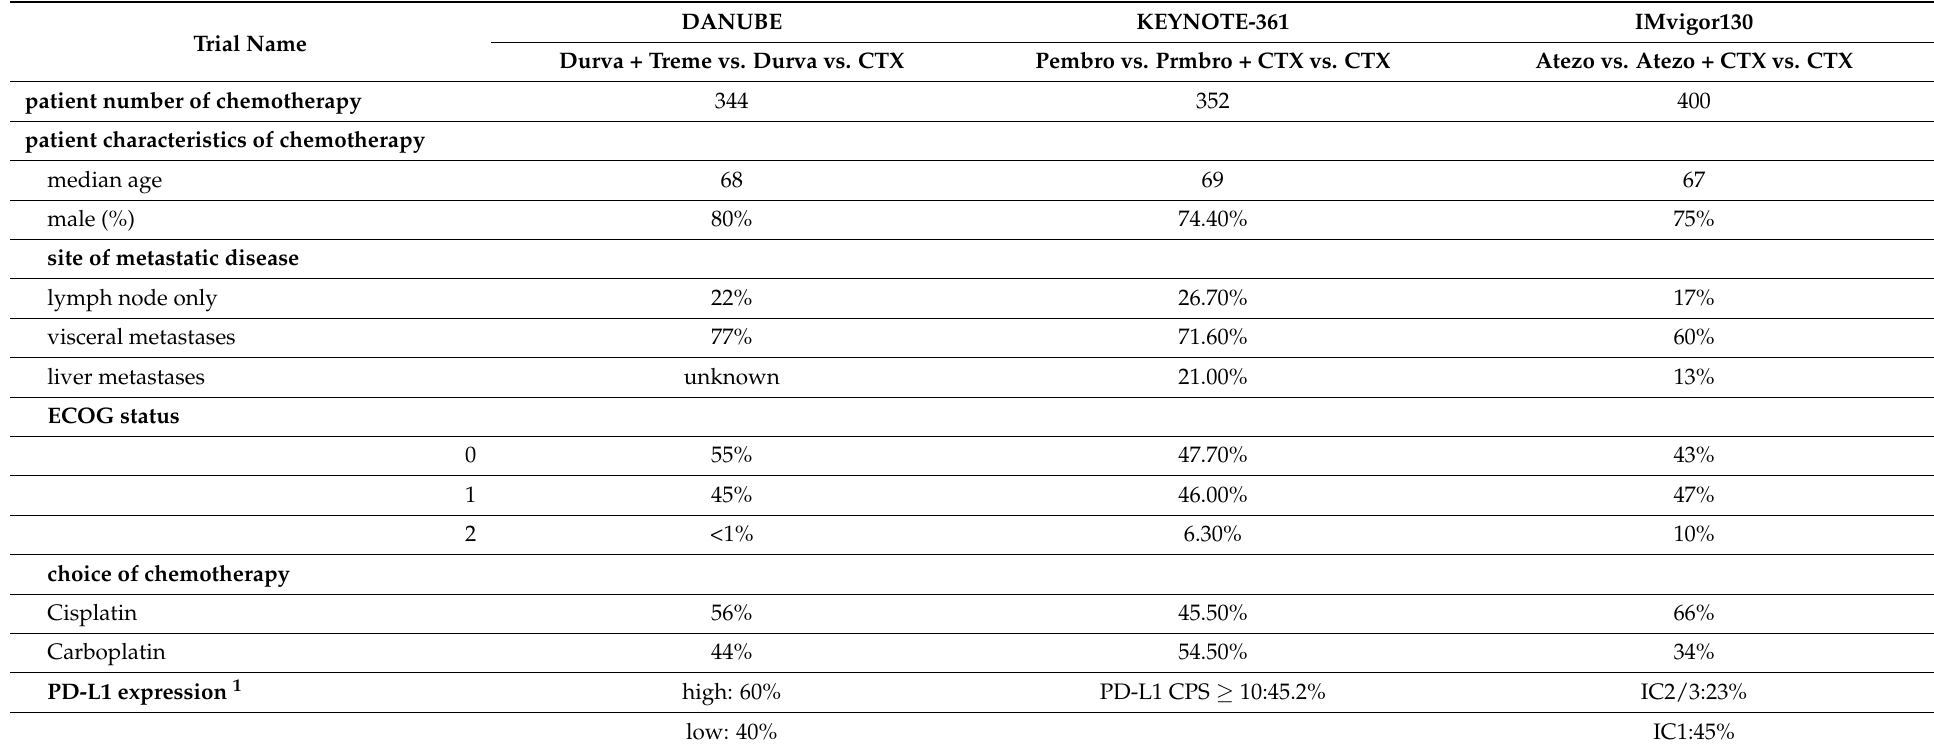
Table A1. Baseline characteristics of patients that received